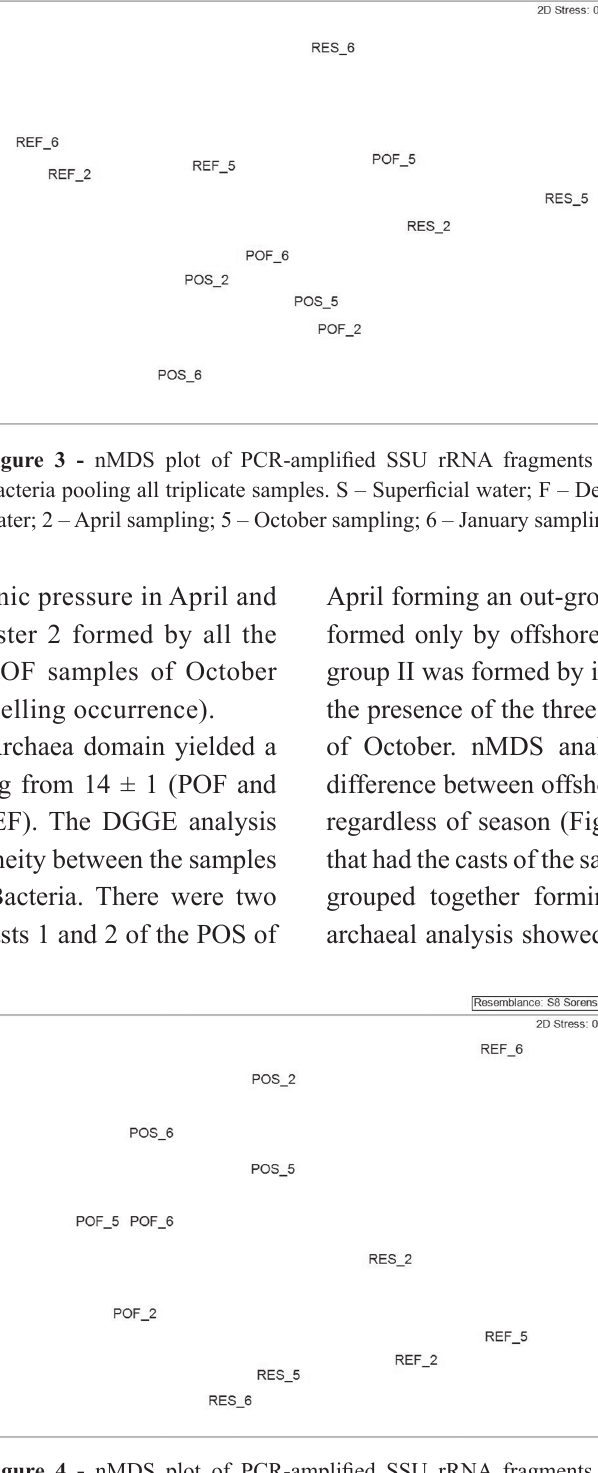
Figure 4 - nMDS plot of PCR-amplified SSU rRNA fragments of Archaea pooling all triplicate samples. S – Superficial water; F – Deep water; 2 – April sampling; 5 – October sampling; 6 – January